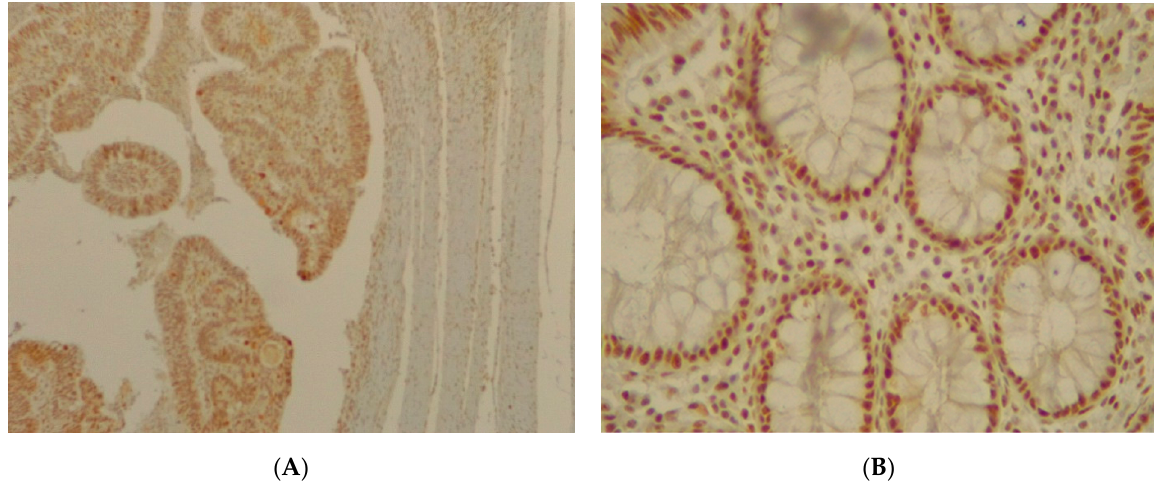
Figure 11. ( A ) Immunohistochemical staining of SMAD4 in colorectal adenocarcinoma with an intensity score of 2+ with more than 50% of the stained cells. ( B ) Immunohistochemical staining of SMAD4 in normal sample.